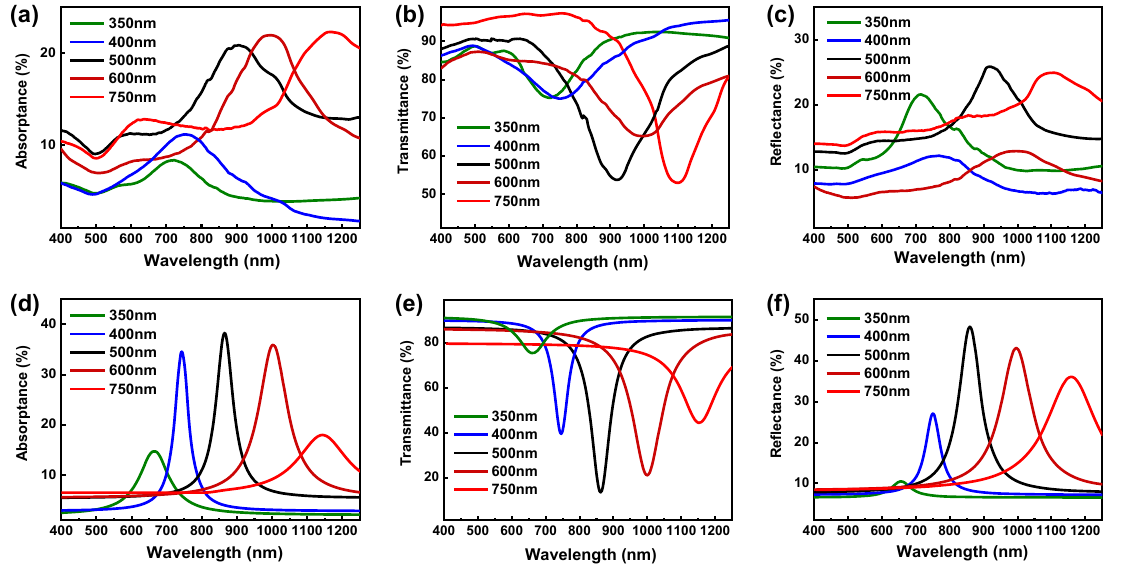
Figure 2: Measured (a – c) and simulated (d – f) absorptance (a, d), transmittance (b, e), and reflectance (c, f) spectra of the Au